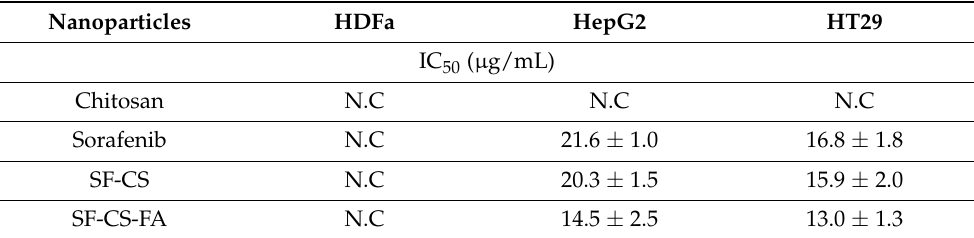
Table 6. The half-maximal inhibitory concentration (IC 50 ) value for chitosan (CS), pristine sorafenib (SF), SF-CS, and SF- CS-FA nanoparticles tested on normal HDFa cells, HepG2 and HT29 cell lines. Nanoparticles